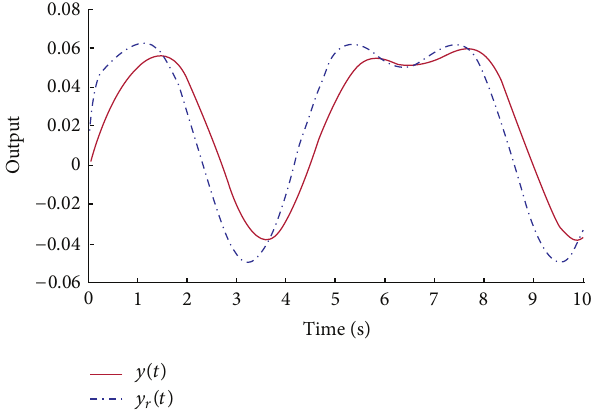
Figure 5: System output tracking trajectory with zero initial condi-